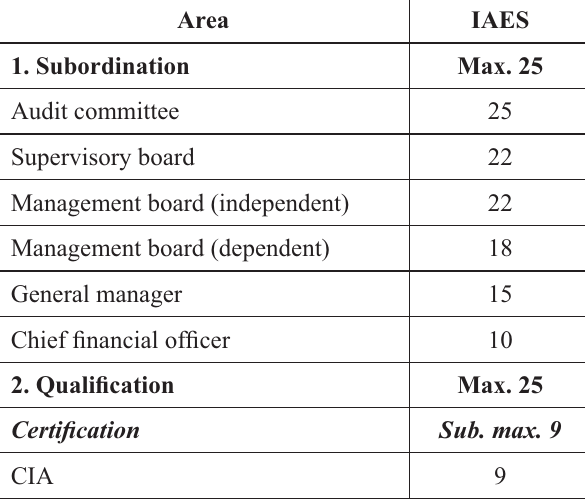
Table 2. Internal Audit Effi ciency Score calculation